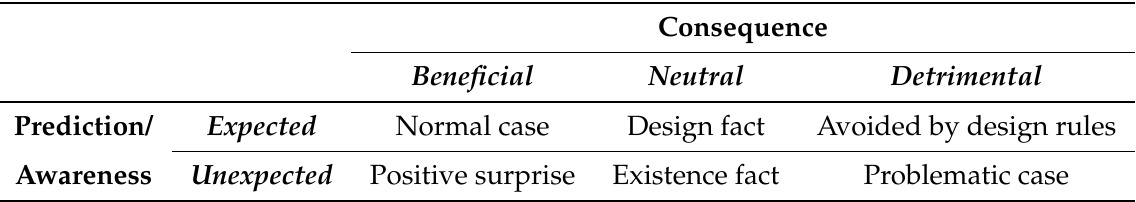
Table 1. Contribution of emergent behavior in a Cyber-Physical Systems of Systems (CPSoS). Adapted from the work in